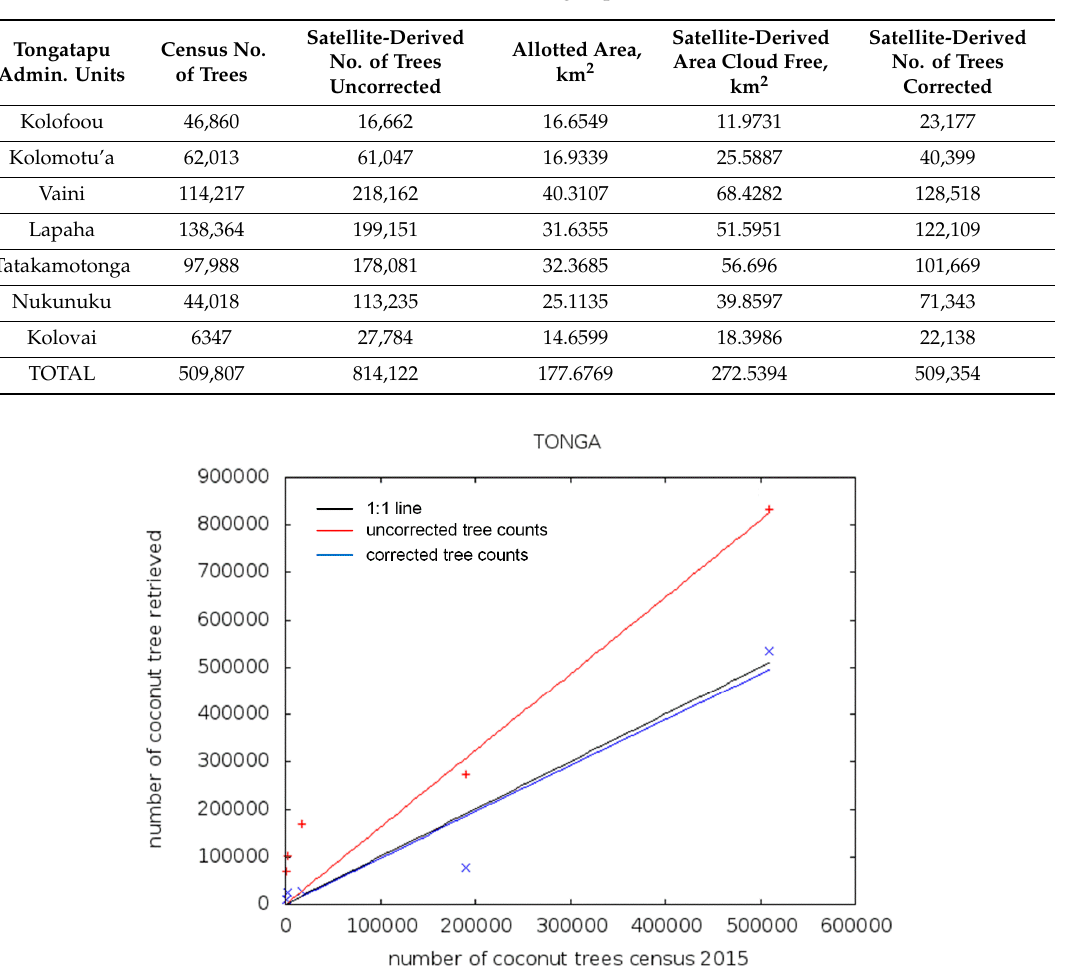
Table 2. Comparison of the algorithm coconut tree counts to the results published in the 2015 agricultural census over the di ff erent administrative unit of the Tongatapu.